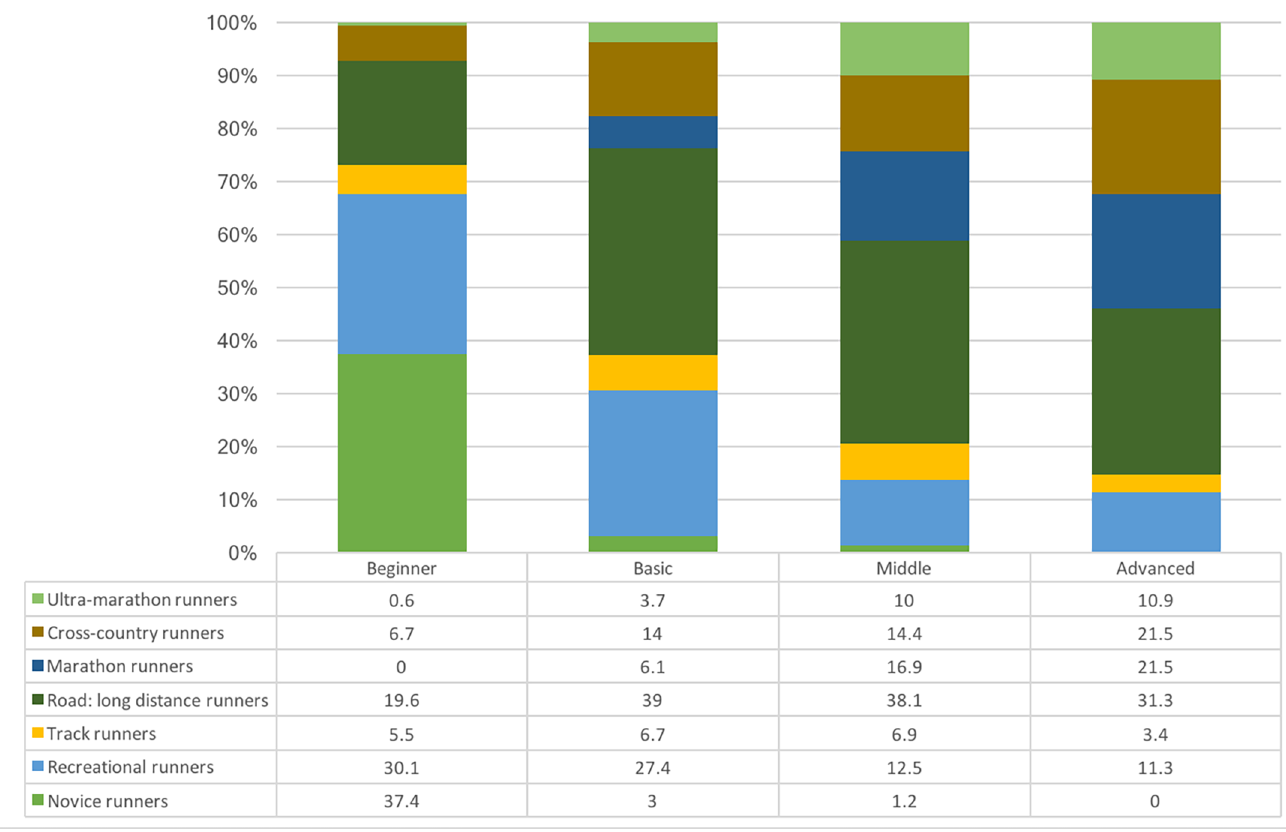
Fig 2. Graphical distribution of Kluitenberg’s classification by